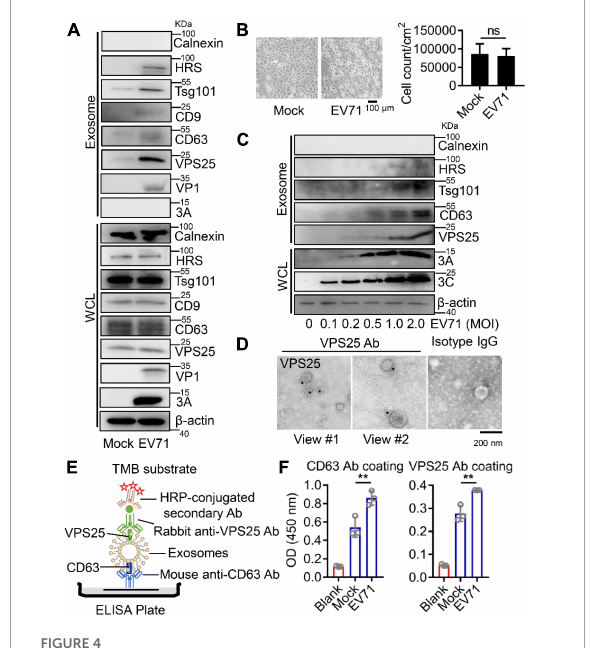
FIGURE4 The location of VPS25 in EV71-induced exosome biogenesis. (A–C) RD cells were mock-infected or infected with EV71 (MOI = 0.5) for 24 h (A,B) . The cell images and count were captured (B) . RD cells were infected with EV71 at different MOIs (C) . At 24 h post-infection, extracted exosomes and cell lysates were analyzed by Western blot. (D) The extracted exosomes from panel (A) were detected by immunoelectron microscopy using anti-VPS25 antibody. (E) Schematic of immunocapture-based ELISA to detect protein on the surface of exosomes. (F) RD cells were mock-infected or infected with EV71 (MOI = 0.5). At 24 h post-infection, exosomes extracted from 10 mL of cell supernatant were detected by ELISA in the CD63 and VPS25 antibodies coating plates, respectively. Ab, antibody. Graph shows as mean ± SD. ns, not-significant. ** P < 0 .